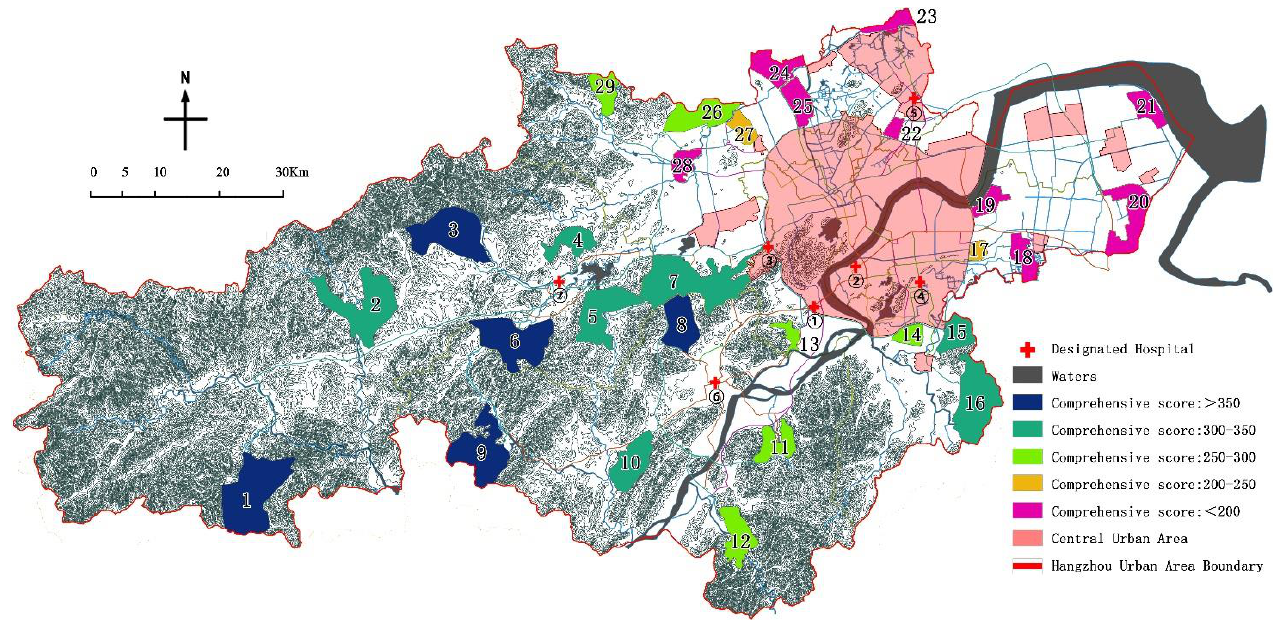
Figure 13. Visualization of the ranking and classification of the country parks.